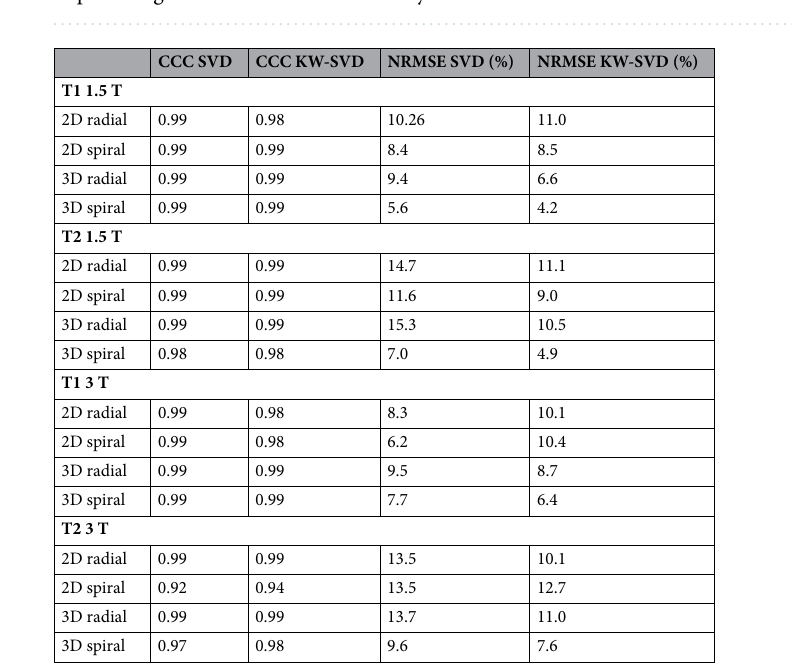
Figure 8. Multipath neural network-based parameter inference—in vitro validation. 95% confidence intervals in percentage differences to the dictionary are − 4.45–6.00% for T1 and − 3.97–6.58% for T2.